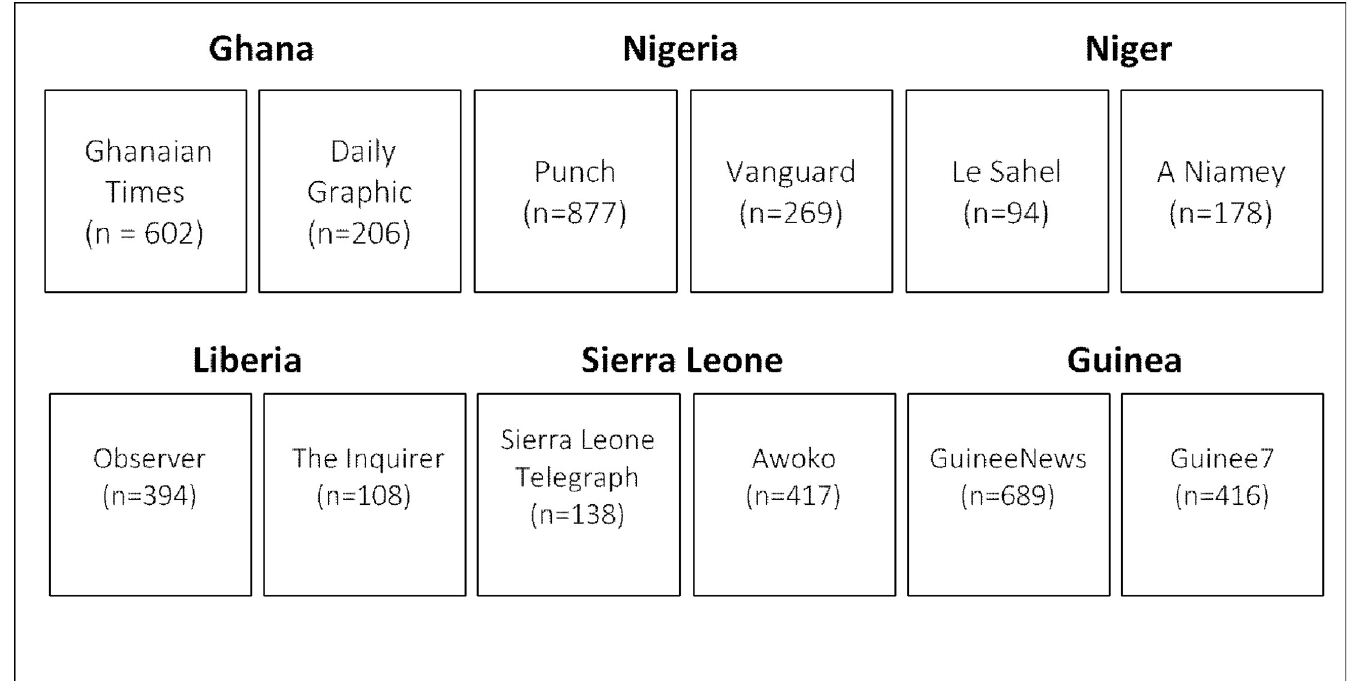
Fig 2. News article inclusion